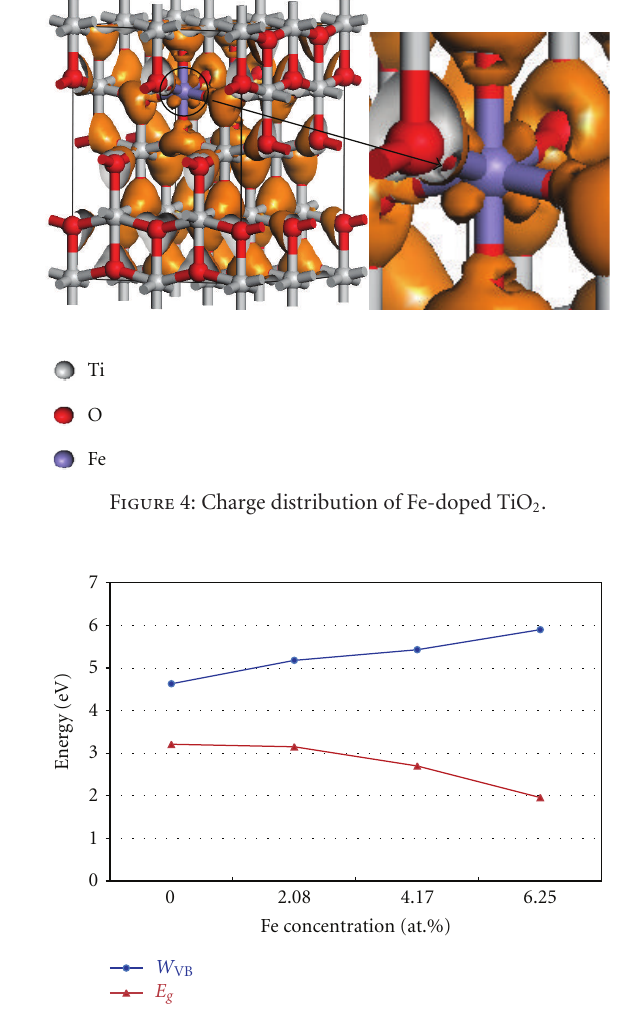
Figure 5: Relationship between band gap ( E g ), valence band width ( W VB ), and Fe concentration for Fe-doped TiO 2